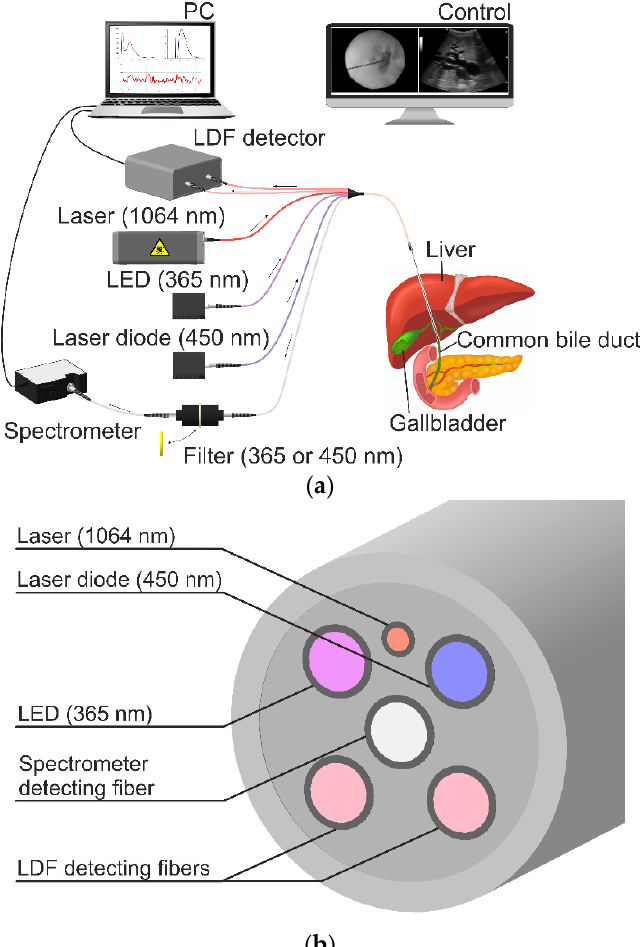
Figure 1. Schematic presentation of installation for experimental studies ( a ) and location of fibers in the laparoscopic probe ( b ).